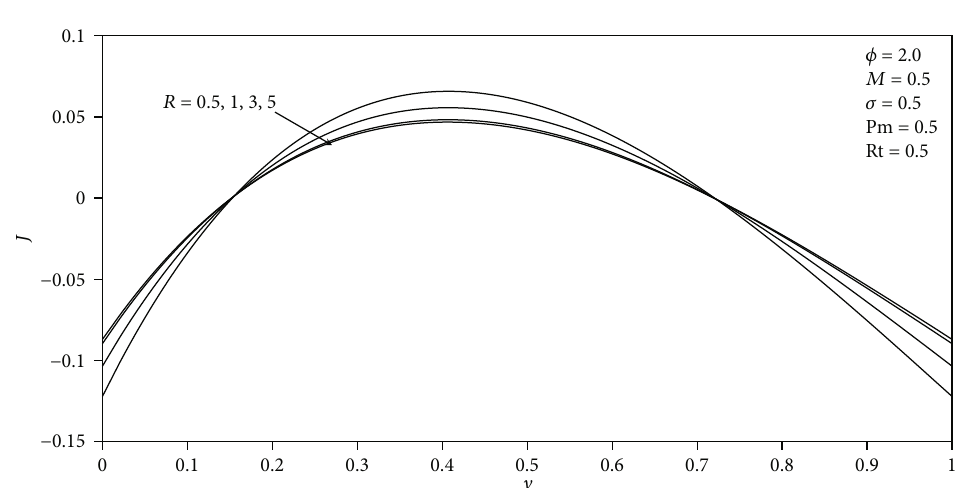
Figure 10: Induced current density for di ff erent values of radiation parameter R